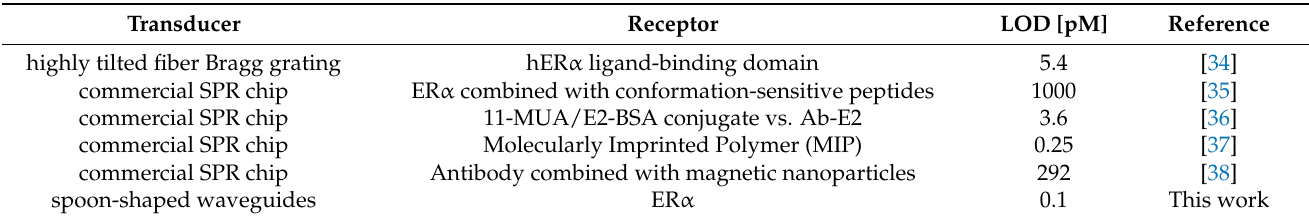
Table 3. Plasmonic sensors for estradiol detection combined with different receptor types.